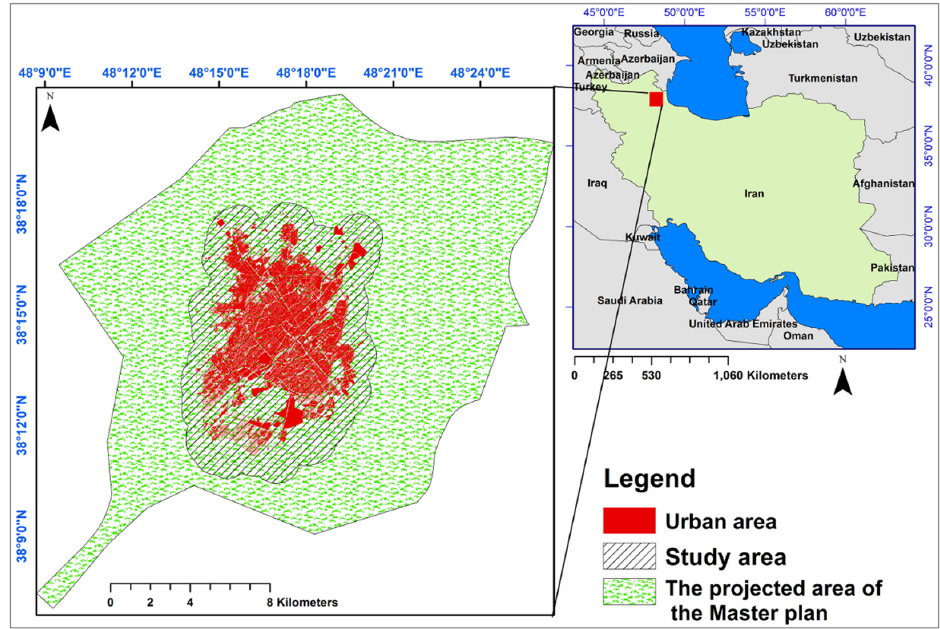
Figure 2. Geographical location of study area. The study area is 1 km around the urban area, affected by the urban extension.